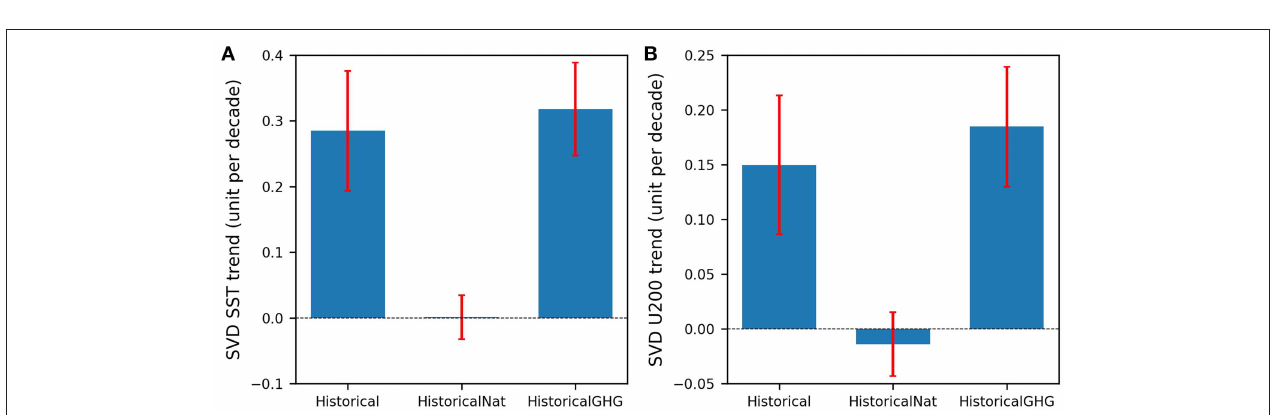
FIGURE 6 | (A) Mean trends of SVD time series of SST (units per decade) estimated from multi-model ensemble for the three CMIP5 numerical experiments (blue bars), model uncertainty (red bars). (B) same as (A) , but for mean trends of SVD time series of